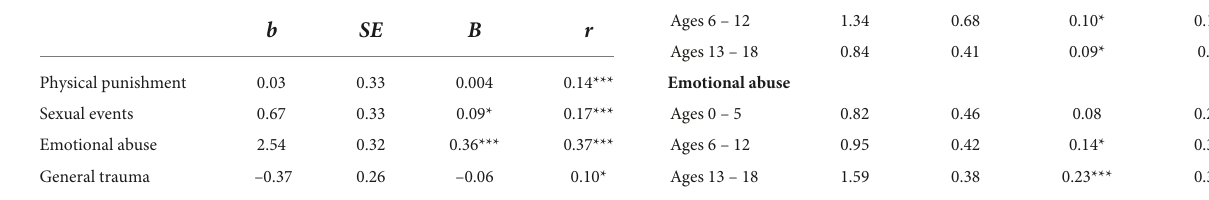
was fully accounted for by diminished perceptions of social support and connection.